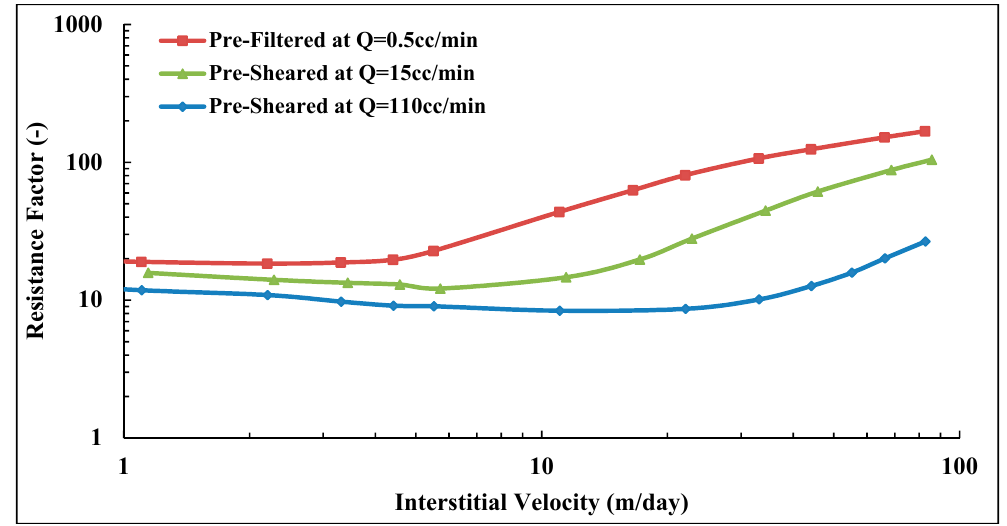
Figure 17. Resistance factor of pre-sheared Solution B at different flow rates versus prefiltered solution.